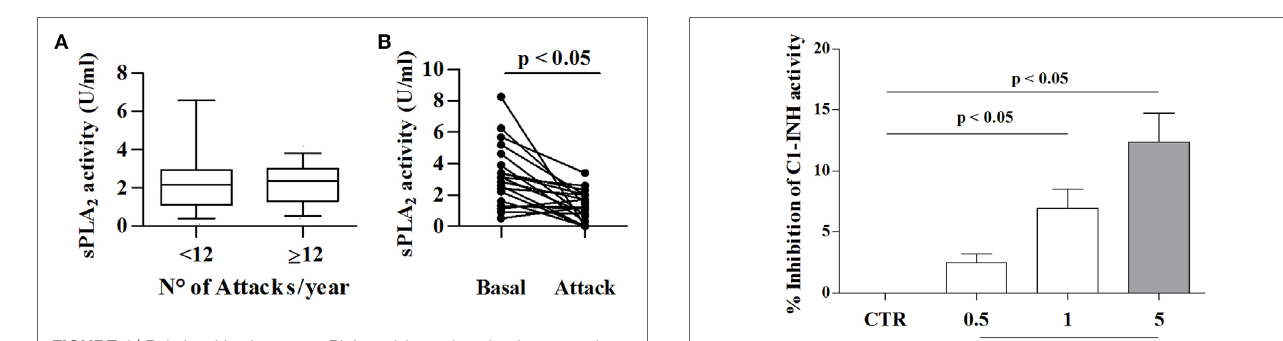
FigUre 4 | Relationships between sPLA 2 activity and angioedema attacks. (a) sPLA 2 activity was determined in 69 patients with low frequency ( < 12/ year) and 40 patients with high frequency ( > 12/year). (B) sPLA 2 activity in plasma collected from 22 patients with C1-INH-HAE patients during symptom-free period (Basal) and during acute attack